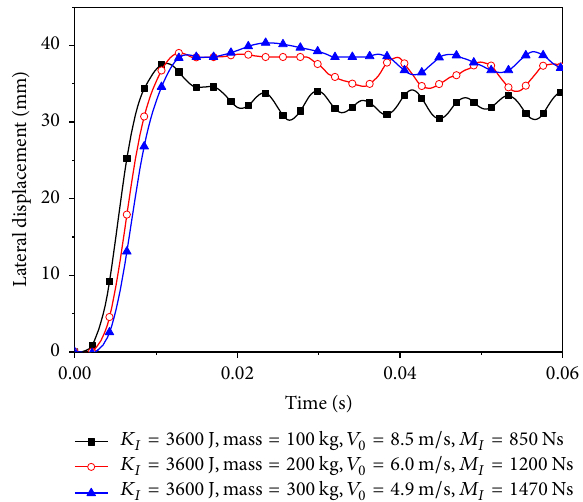
Figure 31: Lateral displacement–time history curve of mid-span of